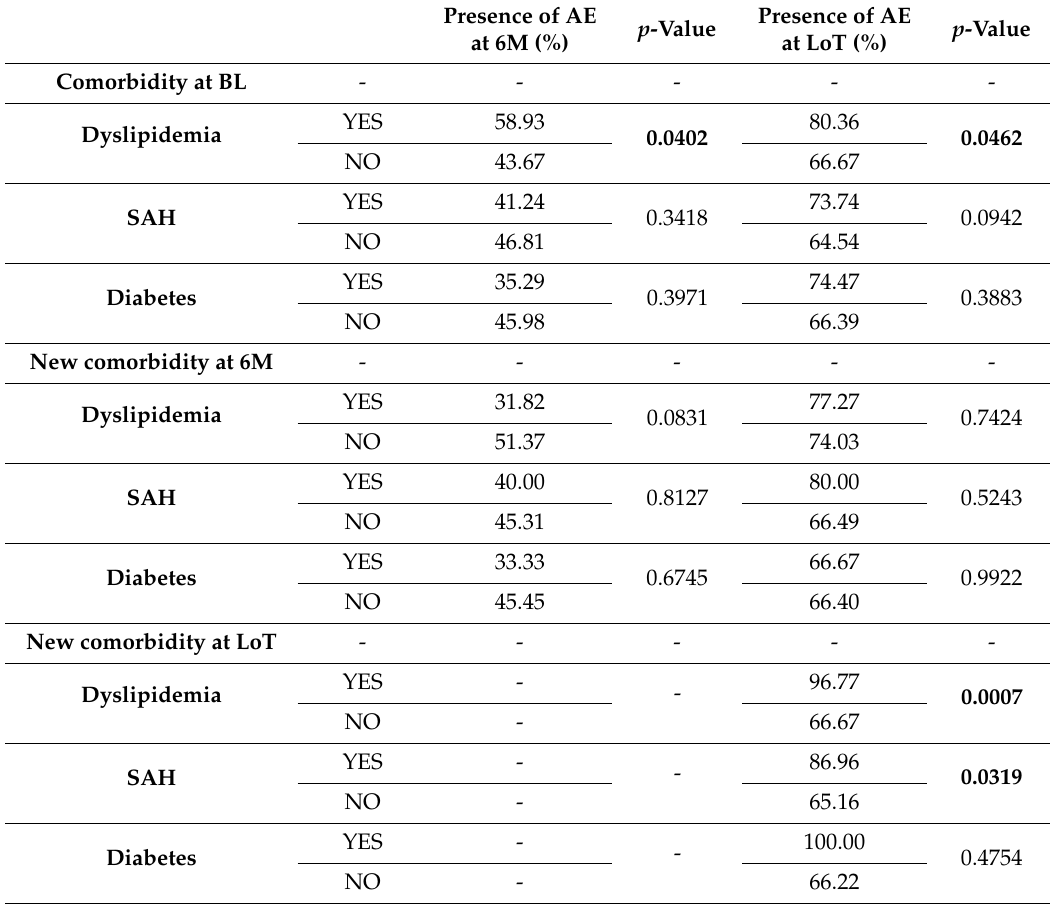
Table 4. E ff ect of comorbidities (present at BL or developed during the treatment) on the development of adverse events (AEs) at 6M and LoT visits (the development of a comorbidity registered at the LoT visit was associated only with the development of AEs at the LoT visit, so the cells of the 6M visit are